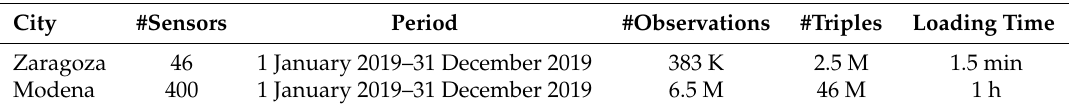
Table 2. Observation data performance evaluation: loading time of hourly observations from